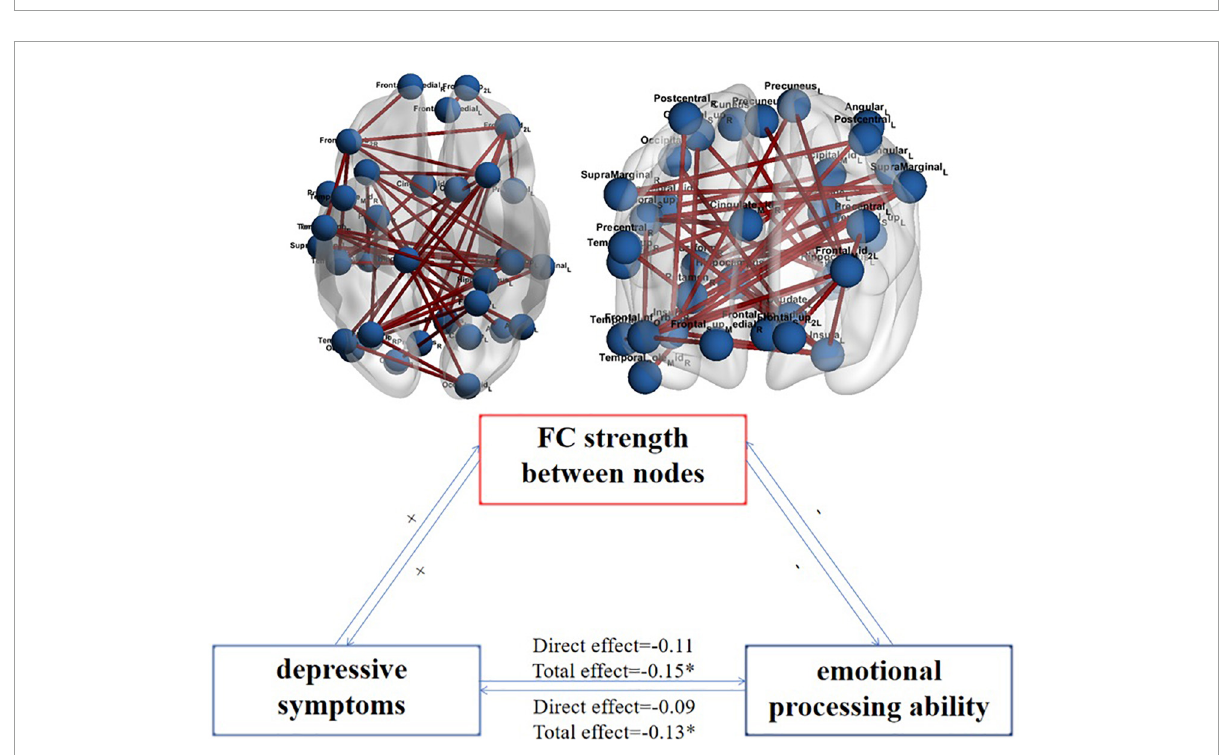
FIGURE2 The FC strength between nodes plays an intermediary role in the interaction between emotion recognition ability and depressive symptoms and their schematic representation. N = 995; the upper figure shows the FCs that play an intermediary role in the interaction between emotion recognition ability and depressive symptoms; the variables on both sides are the DSM score on the depression scale and the average accuracy of the completed emotion recognition task. The lower figure shows that the aggravation of depressive symptoms increases the strength of FC between nodes (+), which makes the ability of emotional recognition worse (-), making the strength of FC between nodes further increase (+) and then more severe depressive symptoms (-). *Represents total effect is significant.